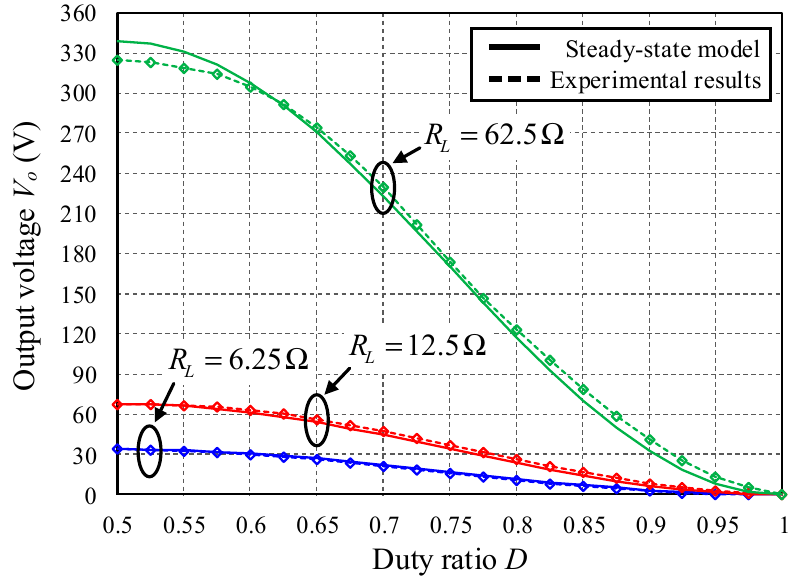
Figure 12. Output voltage versus duty ratio under various load conditions.